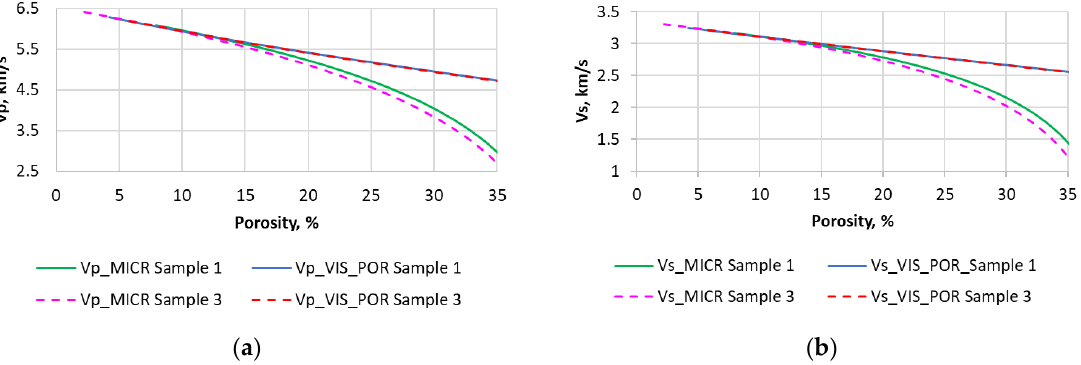
Figure 19. Elastic wave velocities vs. porosity calculated for Sample 1 and Sample 3 for two RP models: for fixed “visible” porosity and varying micrite porosity (MICR) and for fixed micrite porosity and varying “visible” porosity (VIS_POR); ( a ) P-wave velocities and ( b ) S-wave velocities.